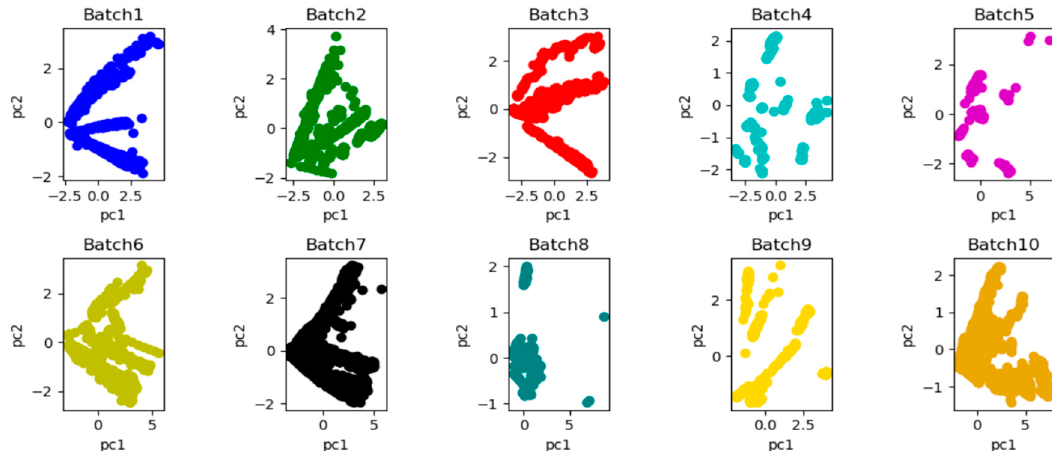
Figure 8. The performance of principal component analysis (PC1 vs. PC2) was performed on the original data of 10 batches by principal component analysis (PCA) (two-dimensional subspace distribution of 10 batches respectively), and the observation of the significant changes in data spatial distribution caused by drift could be observed.